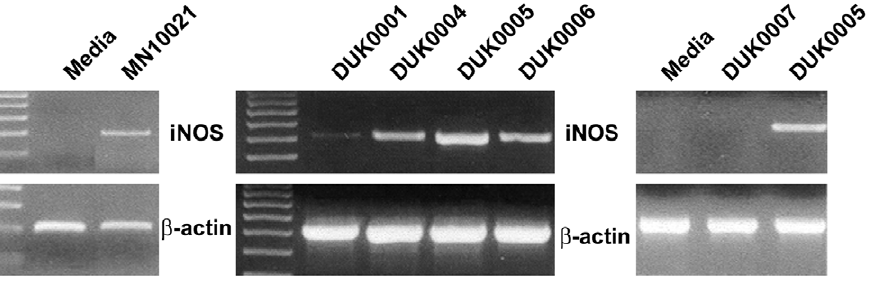
Figure 9. Induction by MN10021 and analogs of mRNA for iNOS in HUVEC. A. HUVEC were grown to 80–90% confluence in 12-well tissue culture plates using defined media provided by Cambrex and supplemented with 10% FBS. The cells were allowed to become quiescent by incubating them overnight in the basal media (without growth factors) supplied by Cambrex and supplemented with 1% FBS. Triplicate wells were incubated with either media alone or media containing 50 m M MN10021 for 3 h at 37 u C, the wells washed with warm PBS, and the cells lysed. Total RNA was isolated, cDNA prepared, and RT-PCR performed as described in Materials & Methods. Primers for human iNOS and b -actin were obtained from R & D systems. B. HUVEC were prepared as described under Methods, grown to 80–90% confluence in 12-well tissue culture plates, and incubated overnight in basal medium (no growth factors) containing 1% FBS in order to make them quiescent. Triplicate wells were incubated for 3 h at 37 u C with 50 m M of one of four different 8-amino acid long analogs of MN10021. DUK0001: NH 2 -GLDLLFLK-COOH; DUK0004: acetyl-GLDLLFLK- acetyl; DUK0005: acetyl-GLDLLFLK-NH 2 ; DUK0006: NH 2 -GLDLLFLK-NH 2 . The wells were washed with warm PBS, and the cells lysed. Total RNA was isolated, cDNA prepared, and RT-PCR performed as described in Materials & Methods. Primers for human iNOS and b -actin were obtained from R &